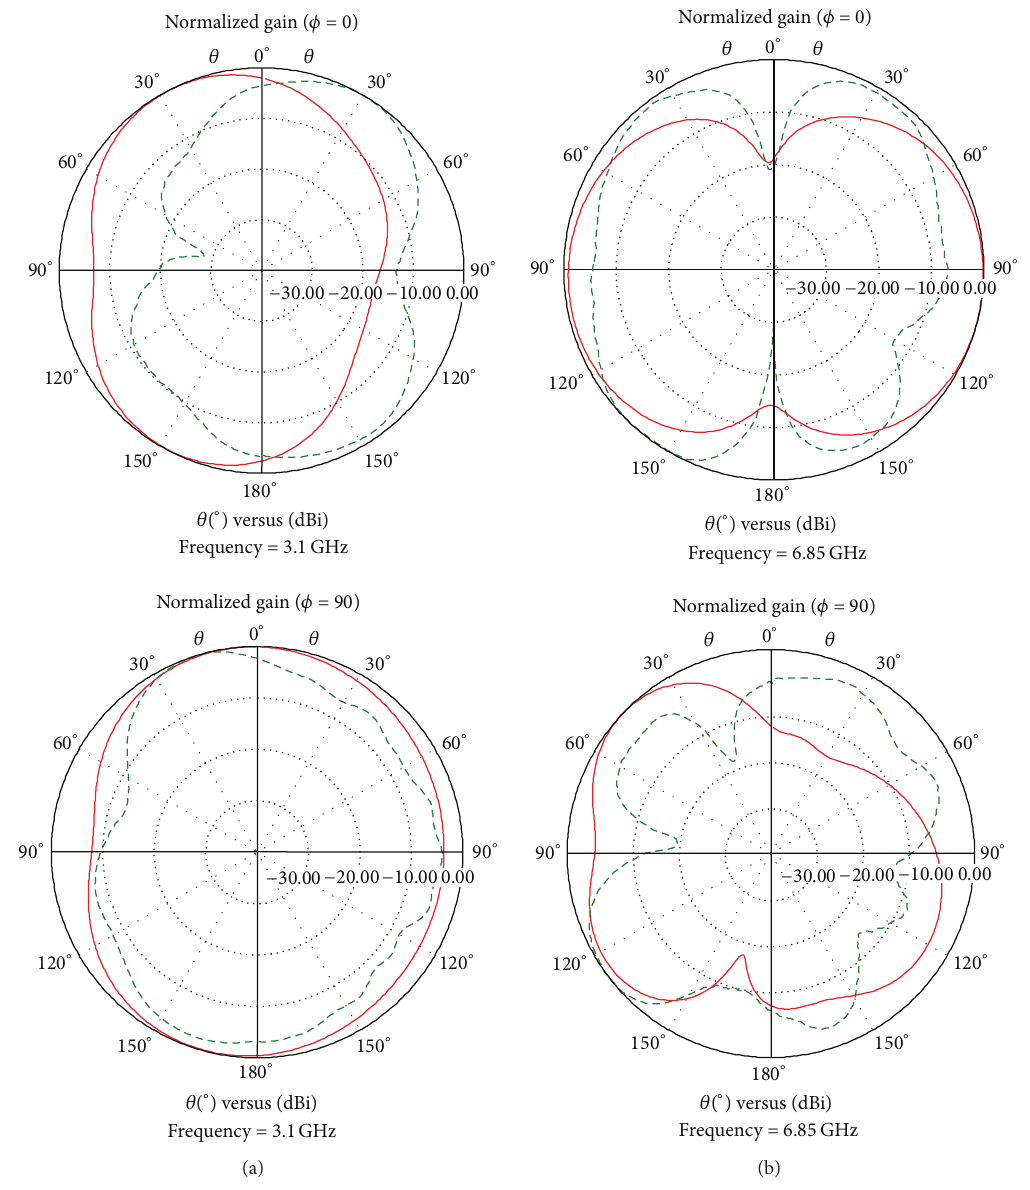
Figure 6: Simulated (solid) and measured (dashed) E-plane and H-plane radiation patterns for the center frequency: (a) 3.1 GHz and (b) 6.85 GHz for OFF state of the